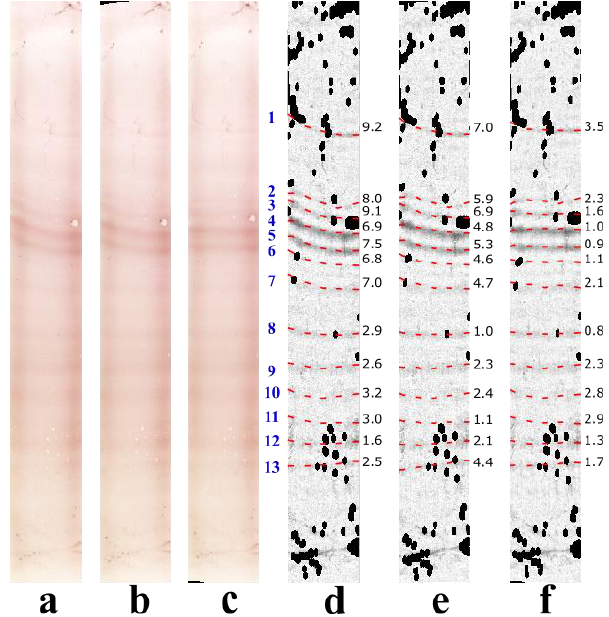
Figure 5. Results of band straightening on a CSF lane: ( a – c ): original colors; ( d – f ): grayscale converted, background subtracted, non-ambiguous artifact in black and contrast ×12 for clarity; ( a , d ): original deformation; ( b , e ): the output of OCBSA-2016; ( c , f ): the output of OCBSA-2021. Bands are shown as red dashed lines, and the corresponding SD are displayed on their right.